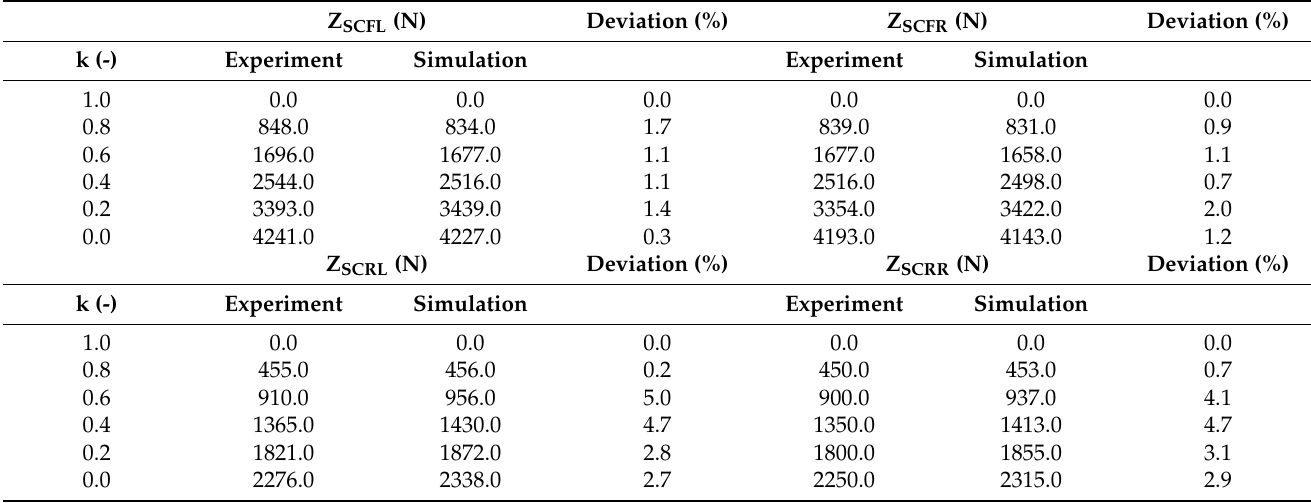
Table 1. Validation of the experimental measurement